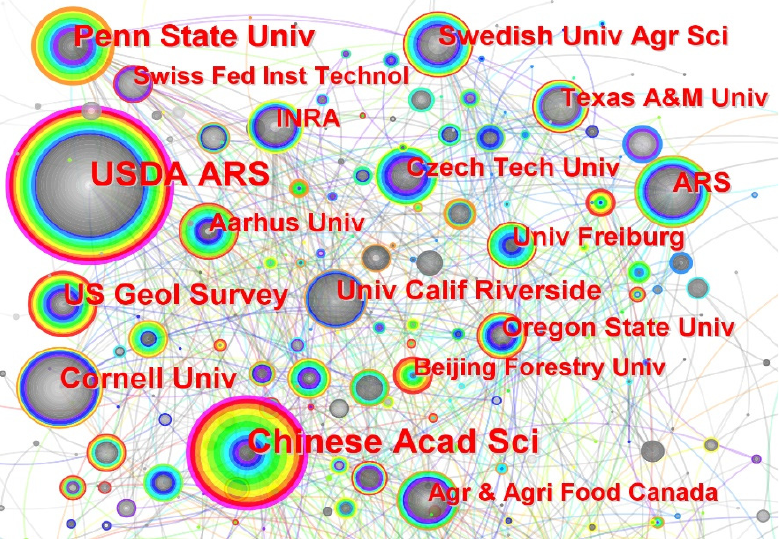
Figure 7. Cooperative network of institutions in preferential flow research in the past 30 years.